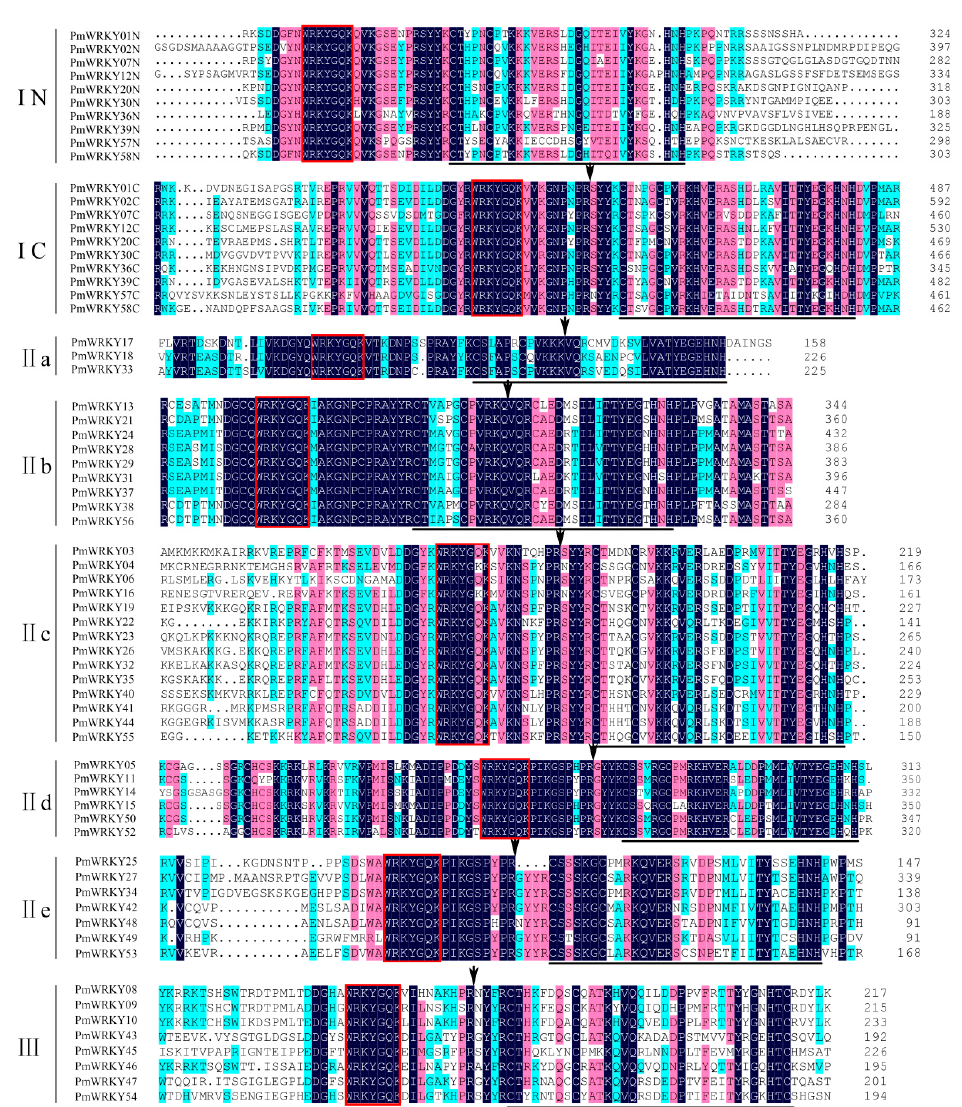
Figure 4. Acid residue alignment of WRKY domain. Alignment was performed using DNAMAN. The suffix ‘N’ and ‘C’ indicate the N-terminal WRKY domain and the C-terminal WRKY domain, respectively. The amino acids forming the zinc-finger motif are underlined in black. The conserved heptapeptide is surrounded by red box. The position of a conserved intron was indicated by an arrow head. The color shade of the amino acid residues highlighted the homology level: dark blue = 100%, pink ≥ 75%, and cambridge blue ≥ 50% .